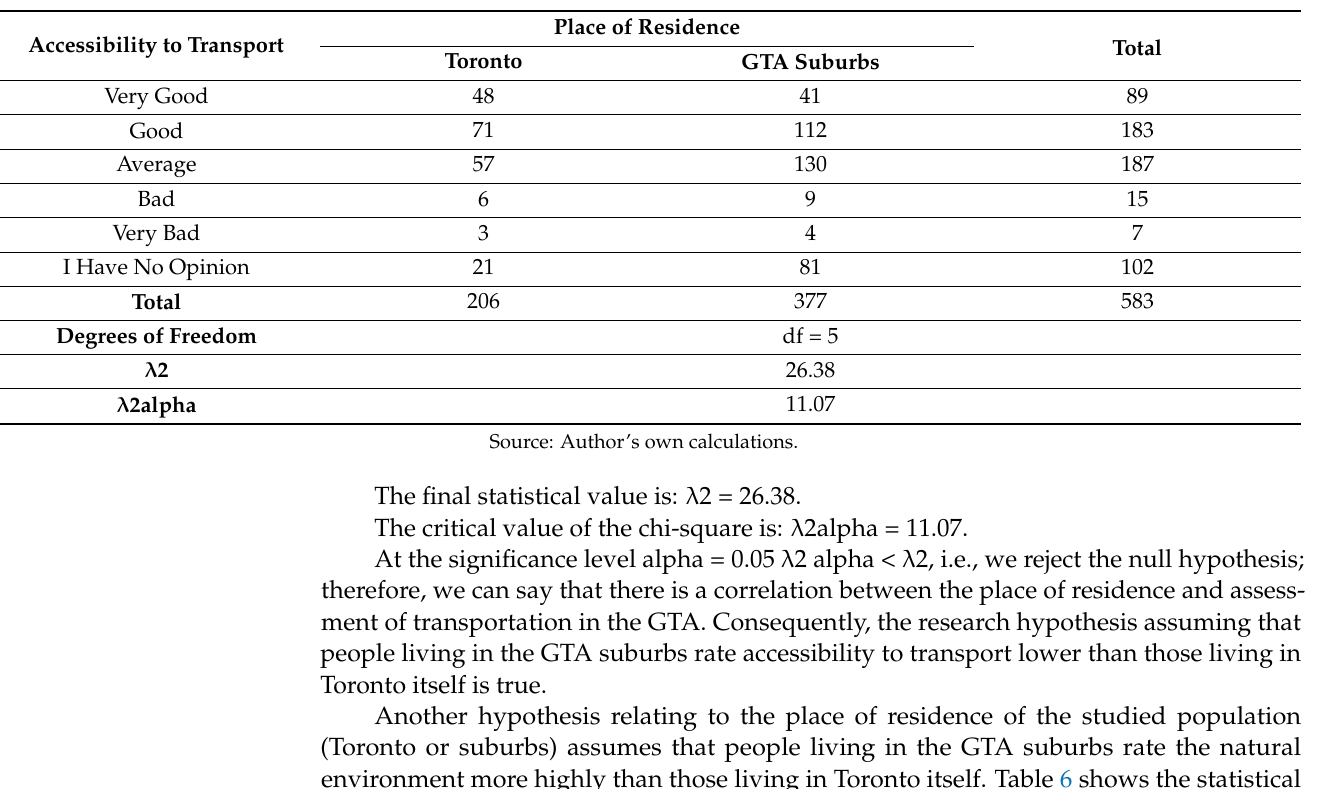
Table 5. Place of residence and accessibility to transport.